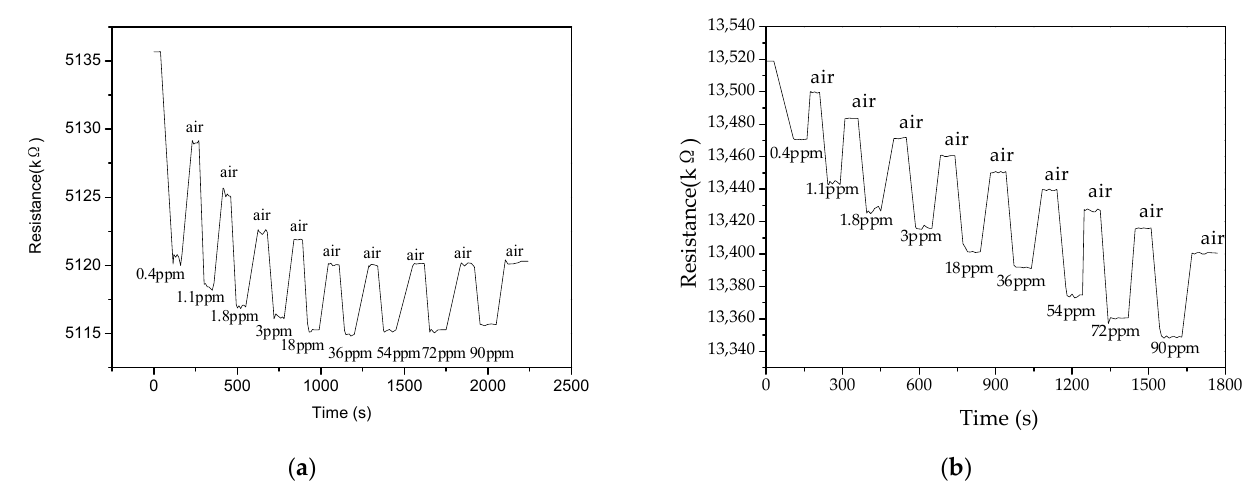
Figure 11. Gas sensor response curves at different benzene vapor concentrations. ( a ) PANI; ( b ) PANI/SnO 2 .